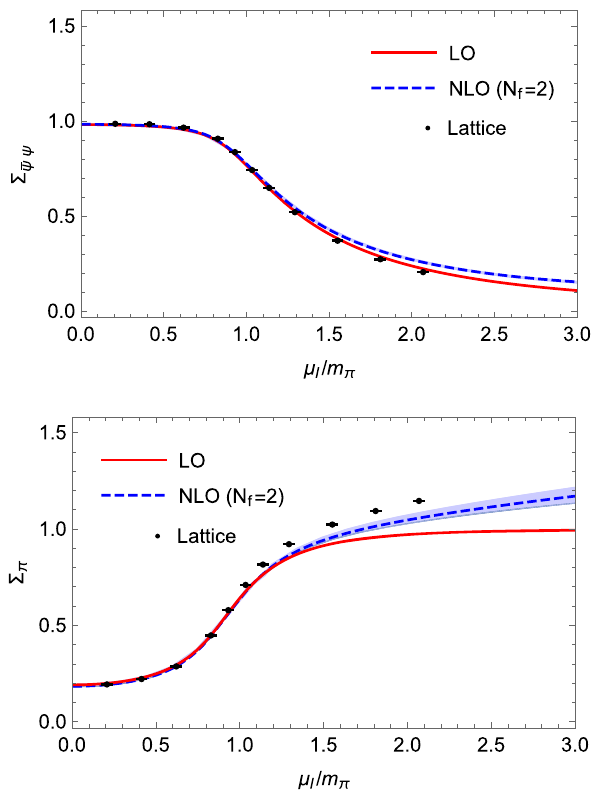
Fig. 3 Top: Quark condensate deviation from the normal vacuum value, Σ ¯ ψψ , at T = 0. Bottom: Pion condensate deviation from the nor- mal vacuum value (which is 0), Σ π , at T = 0 and j = 0 . 00517054 m π . See text in Sect. 5.4 for